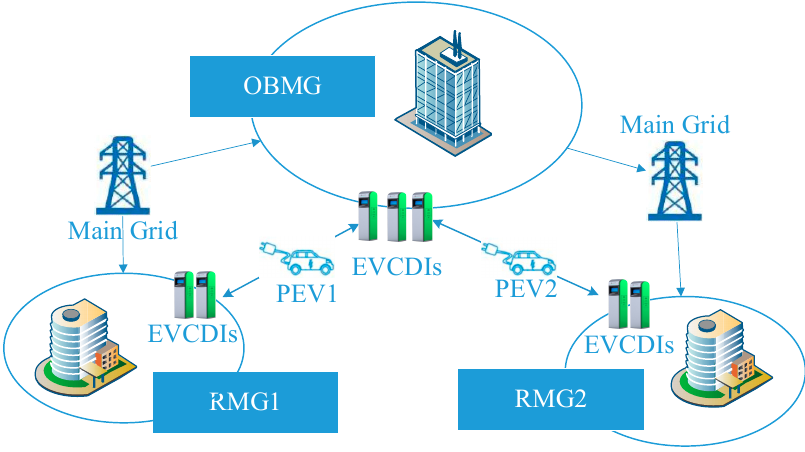
Figure 2. Structure of a classic multi-microgrid system.